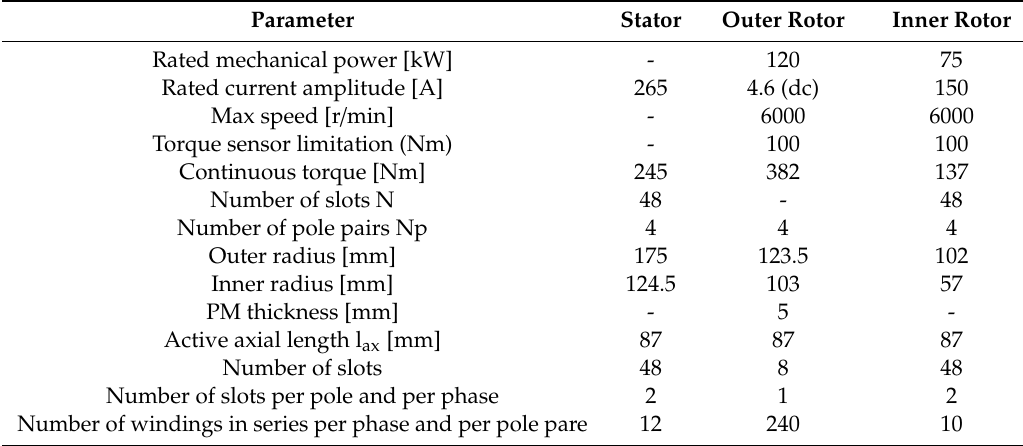
Table 4. Prototype machine